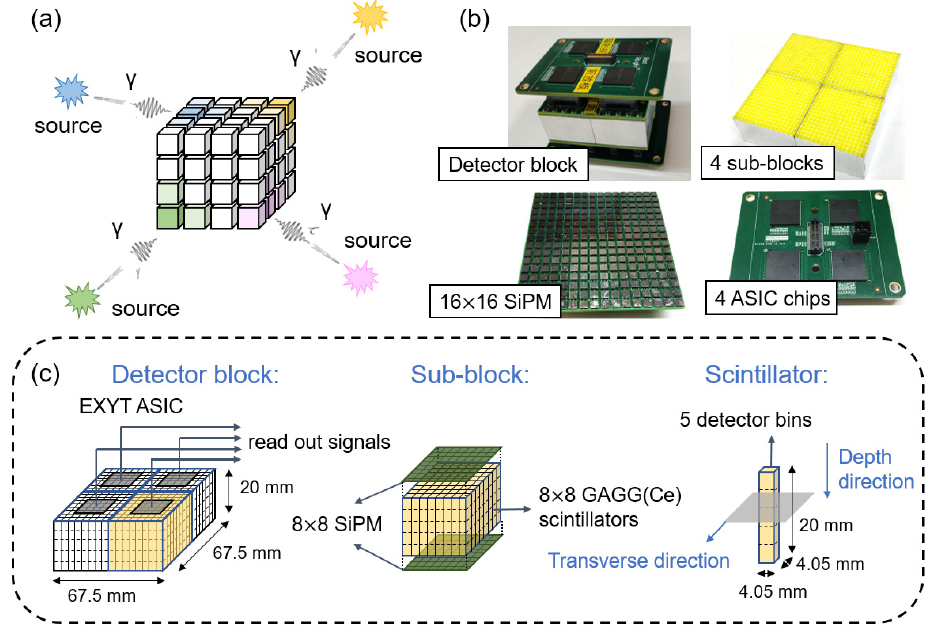
Figure 1. ( a ) Illustration of imaging concept of 3D position-sensitive detector block. ( b ) Pictures of detector block prototype. ( c ) Illustration of the detector block design. detector block prototype. ( c ) Illustration of the detector block